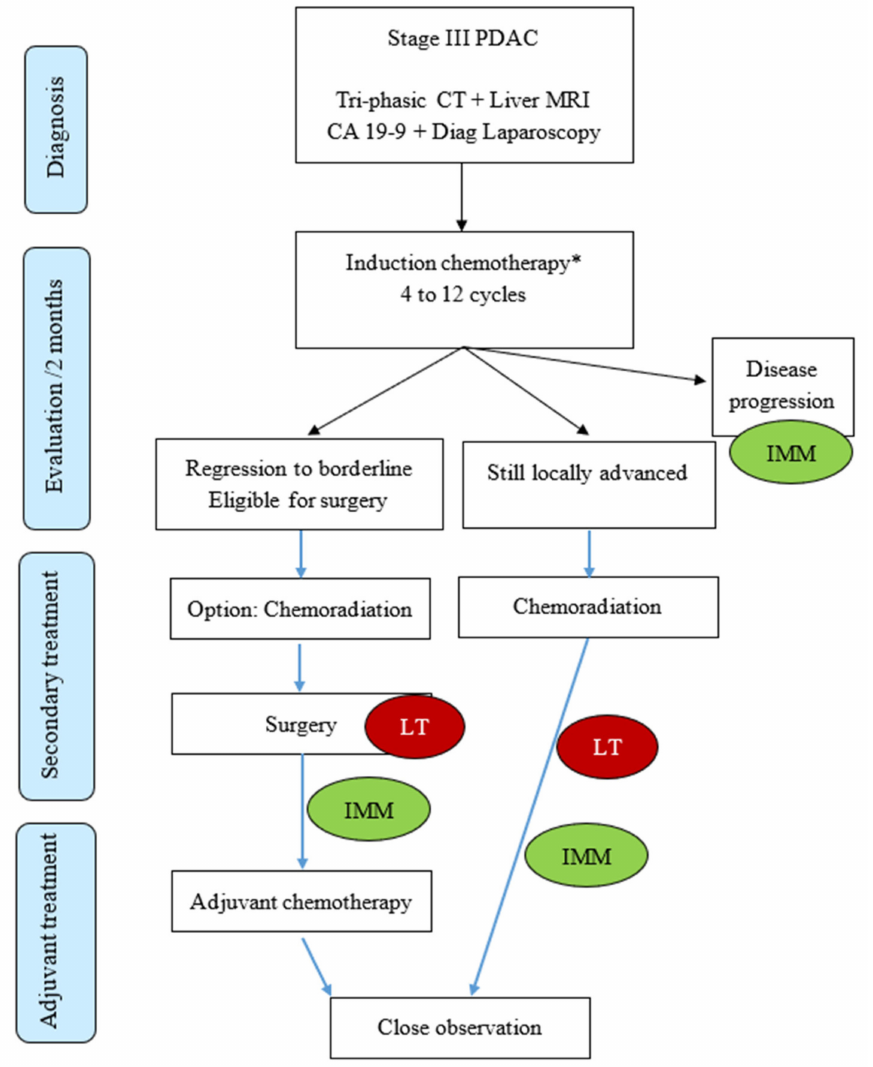
Figure 1. Current therapeutic strategies for locally advanced PDAC. Red and green bubbles indicate potential targets for local therapy (LT) and immunotherapy (IMM), respectively. * FOLFIRINOX or Gemcitabine with Nab-Paclitaxel; CT: computed tomodensitometry; MRI: Magnetic Resonance Imaging; CA 19-9: Carbohydrate Antigen